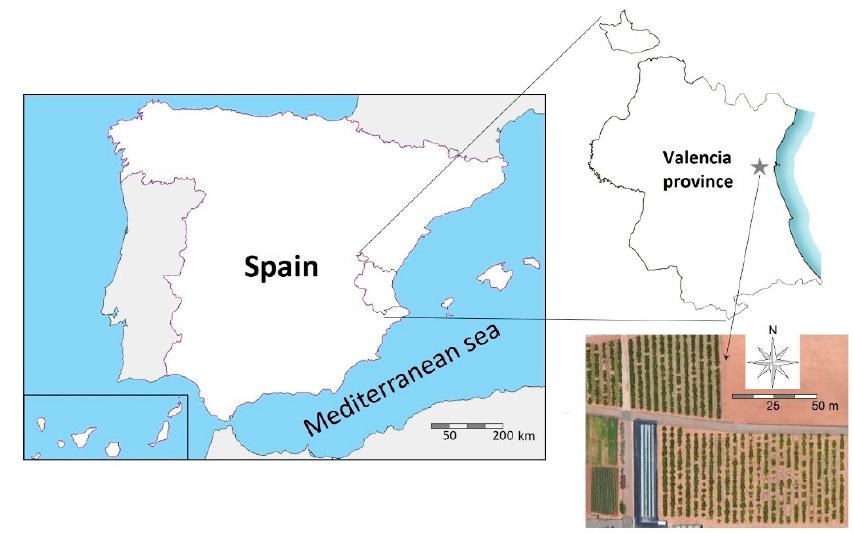
Figure 1. Location of the study site.